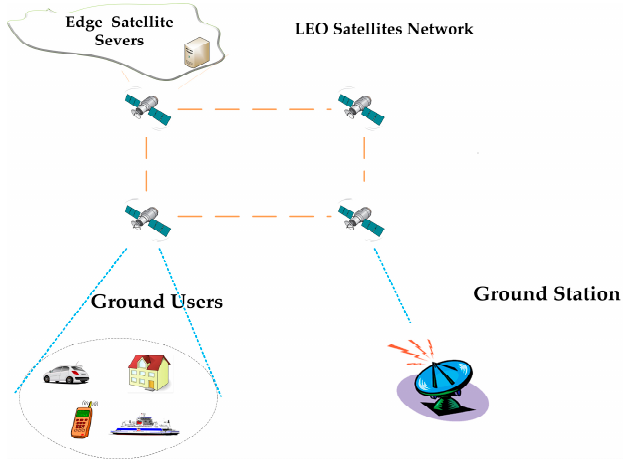
Figure 1. Satellites edge computing architecture.